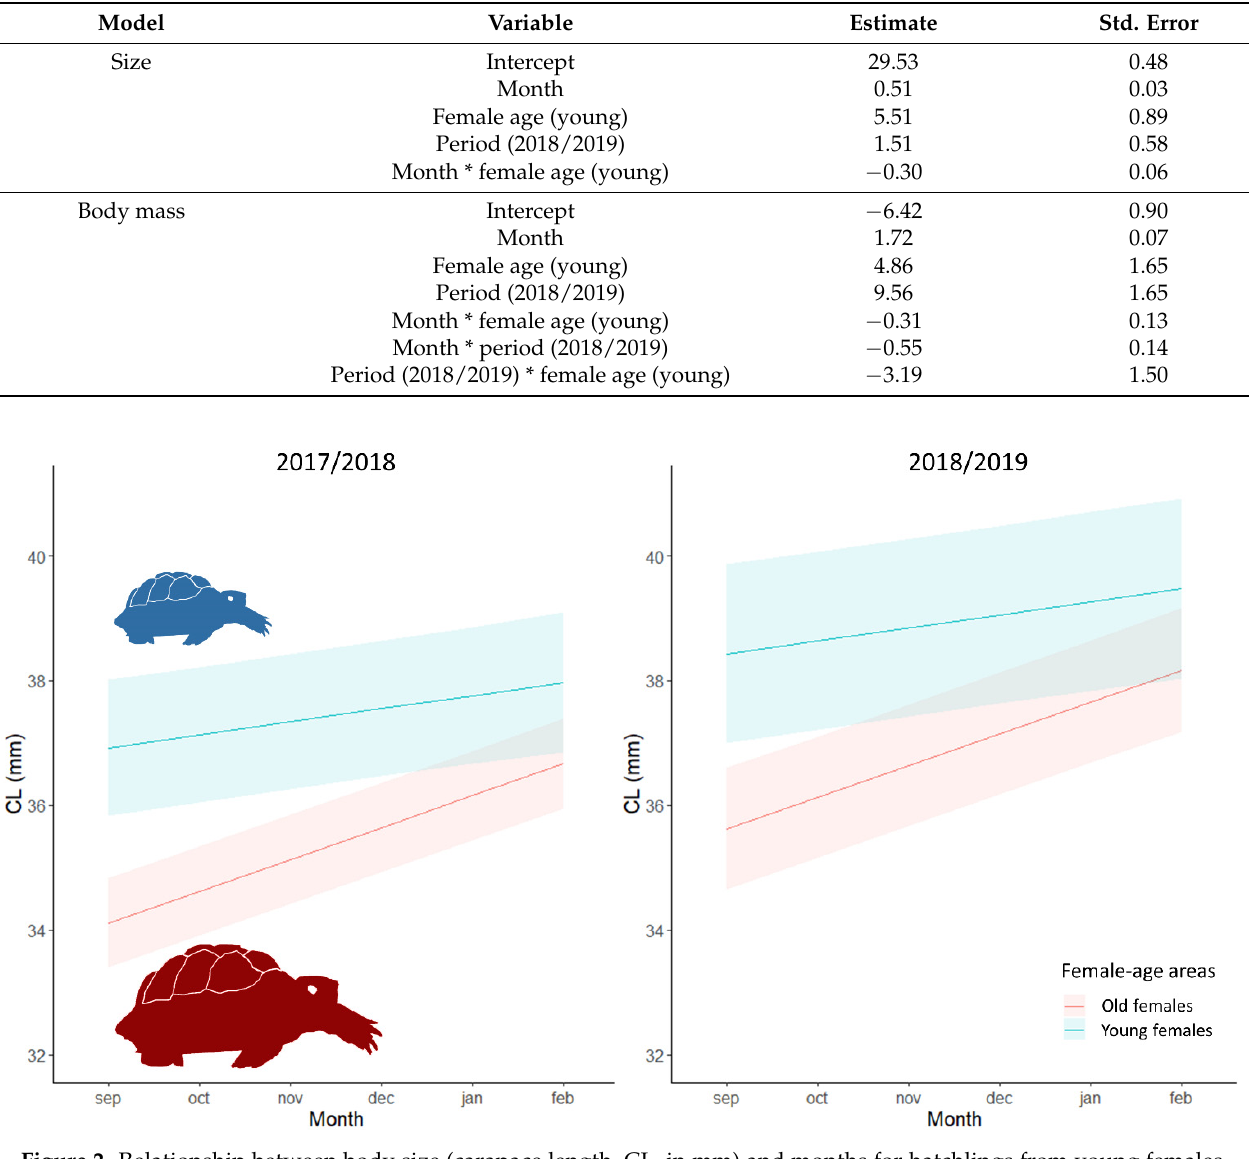
Figure 3. Relationship between hatchling body mass (in g) and months, of young females (in blue) and old females (in red) during the study period. Body mass was calculated with the linear mixed model that best fit the observed data,